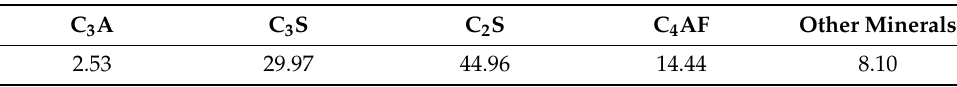
Table 2. Mineral composition of PLH42.5